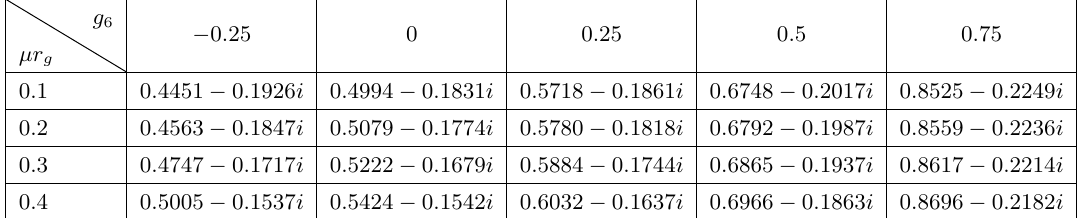
Table 3 . Frequencies ωr g of the fundamental ( n = 0) , first multipole ( ‘ = 1) axial QNMs.